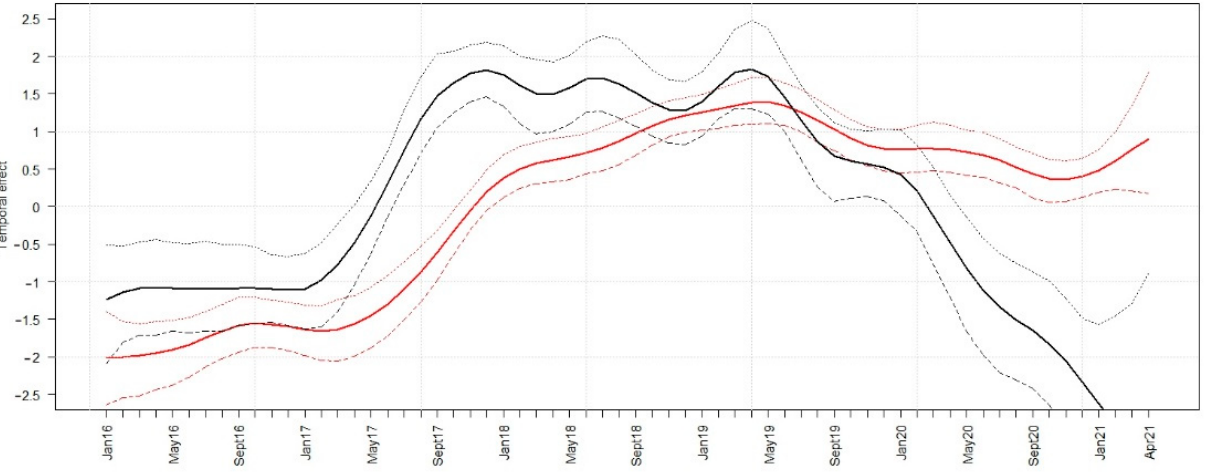
Figure 8. Median temporal effect on the logit prevalence for samples that tested positive for ASFV (black lines) and exclusively seropositive for ASFV-specific antibodies (red lines). The 95% Bayesian credible intervals (BCIs, dashed lines) are indicated for ASFV-positive wild boar (black) and animals exclusively seropositive for ASFV-specific antibodies (red).